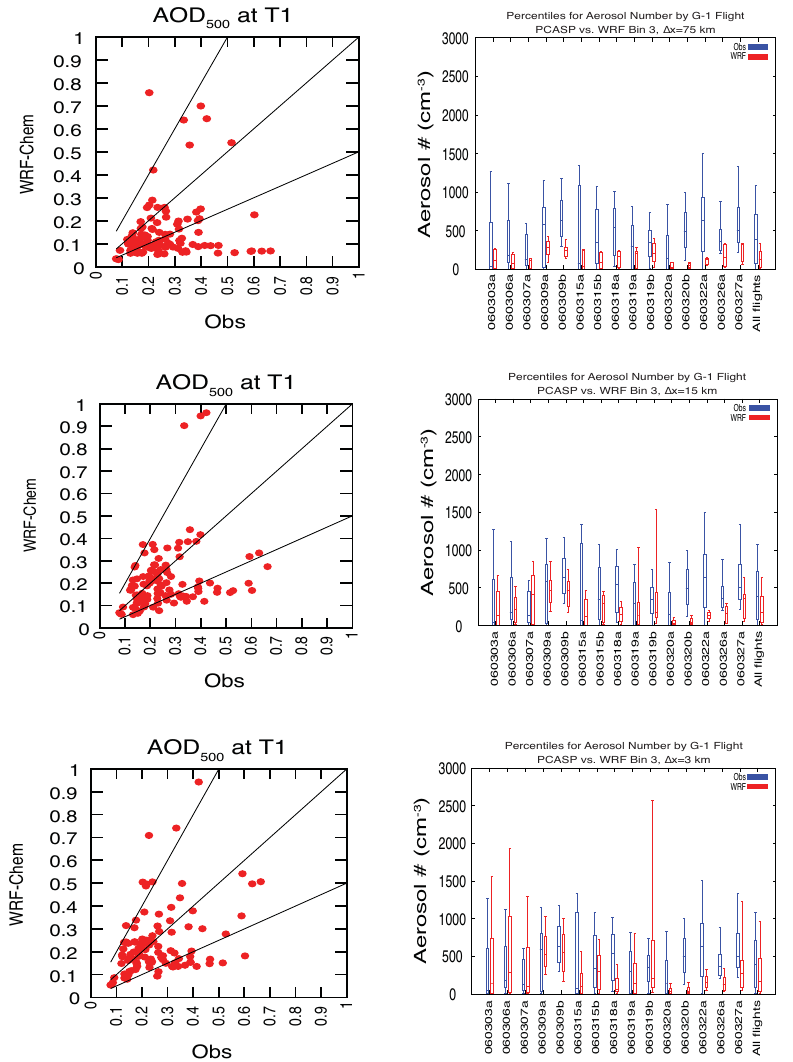
Fig. 8. Scatter plots of observed versus the closest model grid cell simulated AOD at 500nm at T1 (left column) for the 75-km (top), 15-km (middle), and 3-km (bottom) simulations, respectively. Comparison of observed (blue) and simulated (red) aerosol number concentration at for MOSAIC size bin 3 (particle dry diameters between 0.15625 and 0.3125µm,unit: # cm − 3 ) along the G-1 flight paths, where horizontal lines denote the median, boxes denote 25th and 75th percentiles, and vertical lines denote 10th and 90th percentiles (right